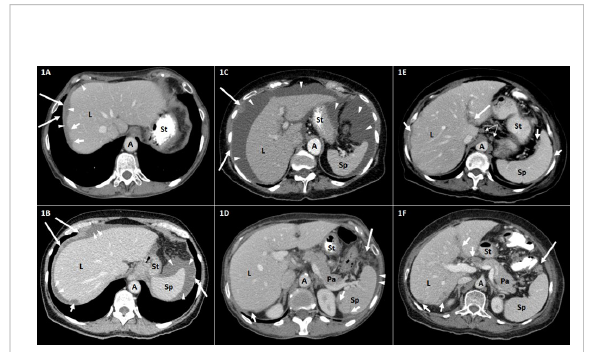
FIGURE 1 Representative CT fi ndings in the upper abdomen in patients with advanced ovarian carcinoma FIGO stage III – IV. Axial contrast-enhanced CT scans of the upper abdomen (A – F) . A, aorta; L, liver; Pa, pancreas; Sp, spleen; St, stomach. (A, B) Tumor implants of the diaphragm (long arrows) and the liver (short arrows). The thickening of the right hemidiaphragm (long arrows) can be distinguished from surrounding perihepatic ascites (arrowheads). The surface tumor deposit at the dome of the liver (short arrows) causes scalloping of the lateral (A) and posterior (B) liver surface. (C) Large amount of ascites (arrowheads) in the upper abdomen. Peritoneal knotty implants (long arrows) are shown. (D) Tumor scalloping (short arrows) of the posterior surface of the spleen and the liver. Small amount of perisplenic ascites (arrowheads). Fat tissue stranding and tumor nodularity (long arrow) are seen in the fat adjacent to the splenic fl exure of the colon. (E) Tumor implants (long arrow) along the hepatogastric ligament. Peritoneal thickening and tumor scalloping of the surface of the spleen and the liver (short arrows). Round suprarenal lymph nodes (narrow arrows). (F) Tumor implants (short arrows) in the porta hepatis along the falciform ligament and of the posterior liver surface. Tumor nodule (long arrow) is seen in the fat adjacent to the splenic fl exure of the colon. FIGO, International Federation of Gynecology and Obstetrics.